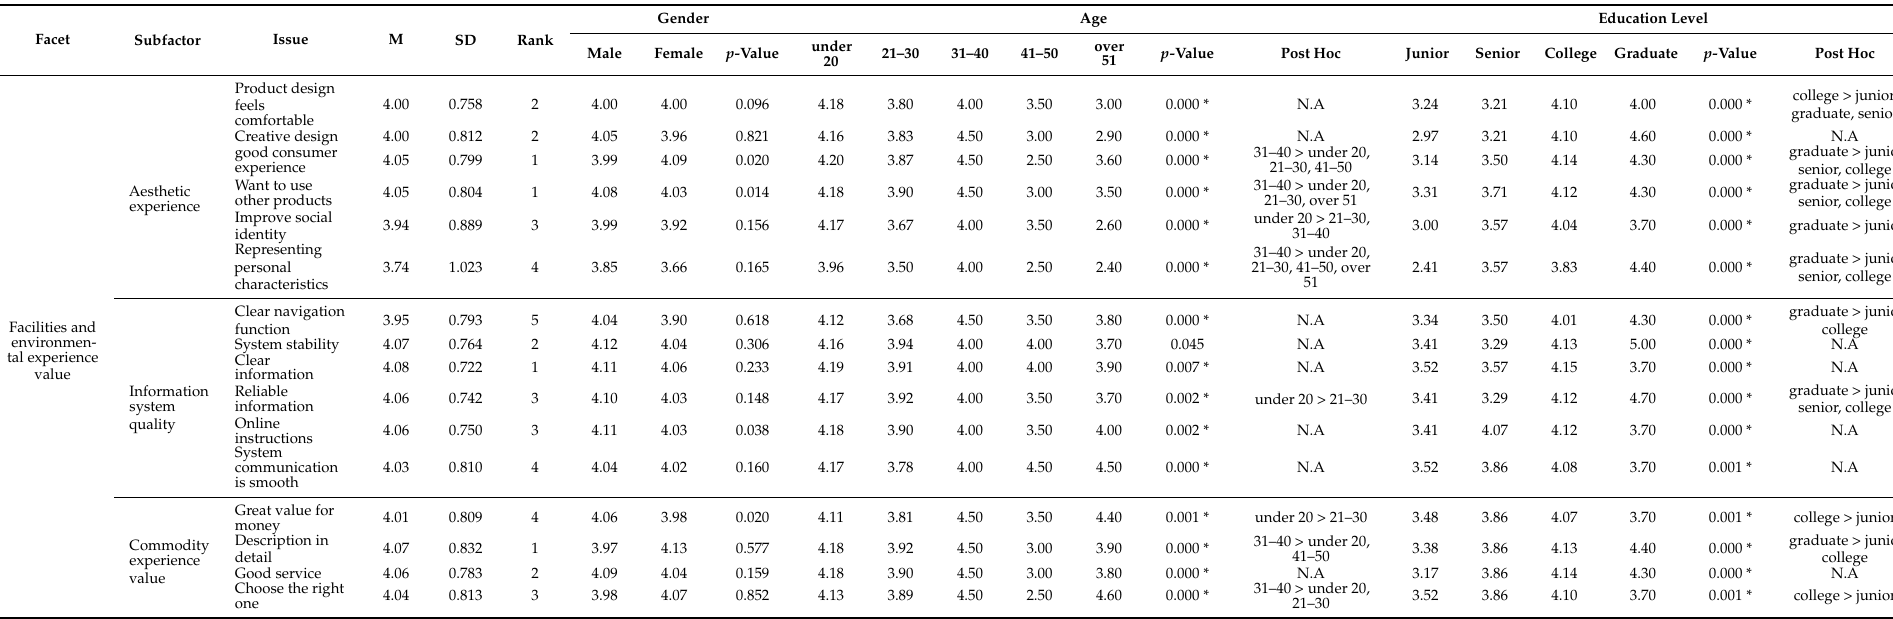
Table 4. Analysis of cognitive differences in environmental experience value, leisure involvement, leisure satisfaction, and